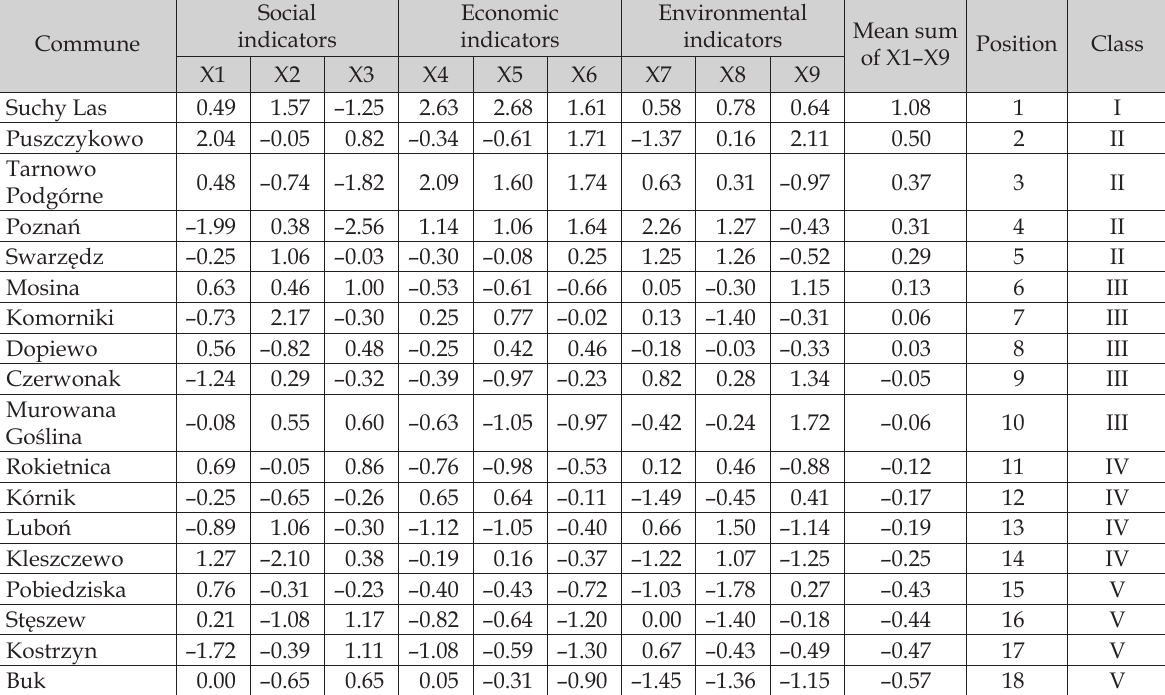
Table 4. Classification of the agglomeration’s communes by the synthetic indicator of determinants of the qual - ity of